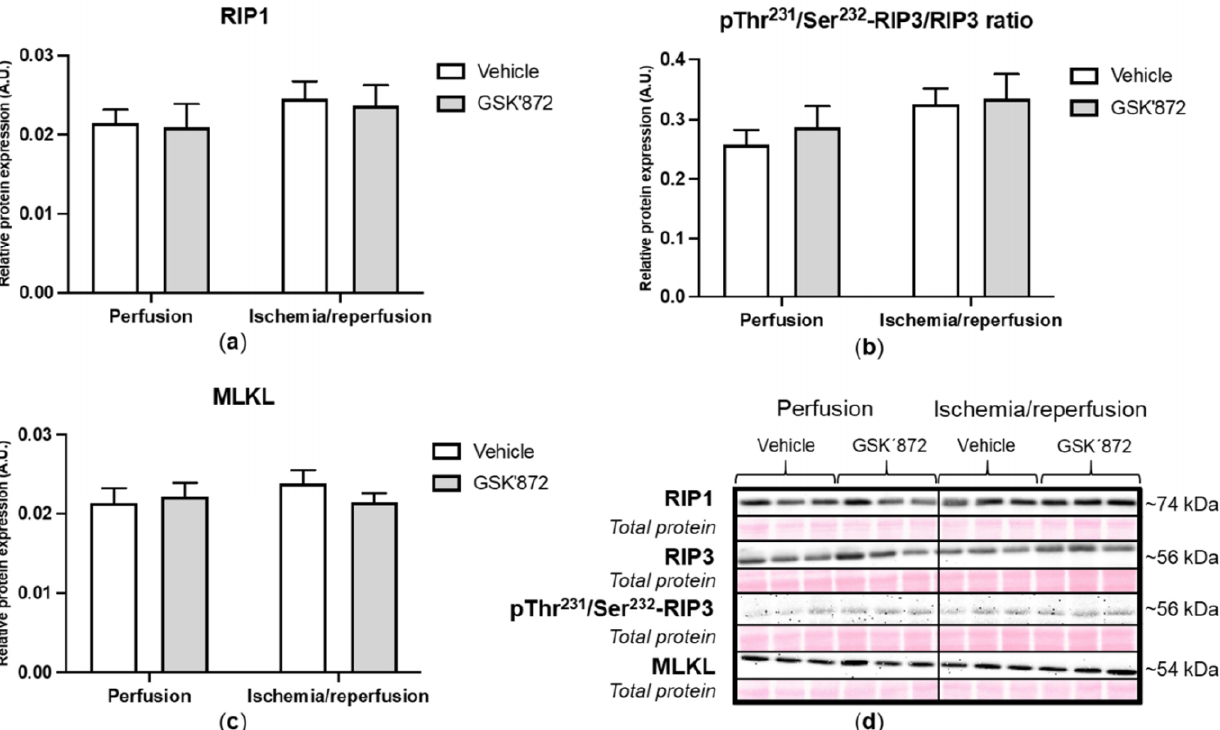
Figure 4. Analysis of activation of canonical necroptotic pathway in left ventricles lysates. Immunoblot quantification of RIP1 ( a ), pThr 231 /Ser 232 -RIP3/RIP3 ratio ( b ) and MLKL ( c ); representative immunoblots and total protein staining ( d ). Data are presented as mean ±